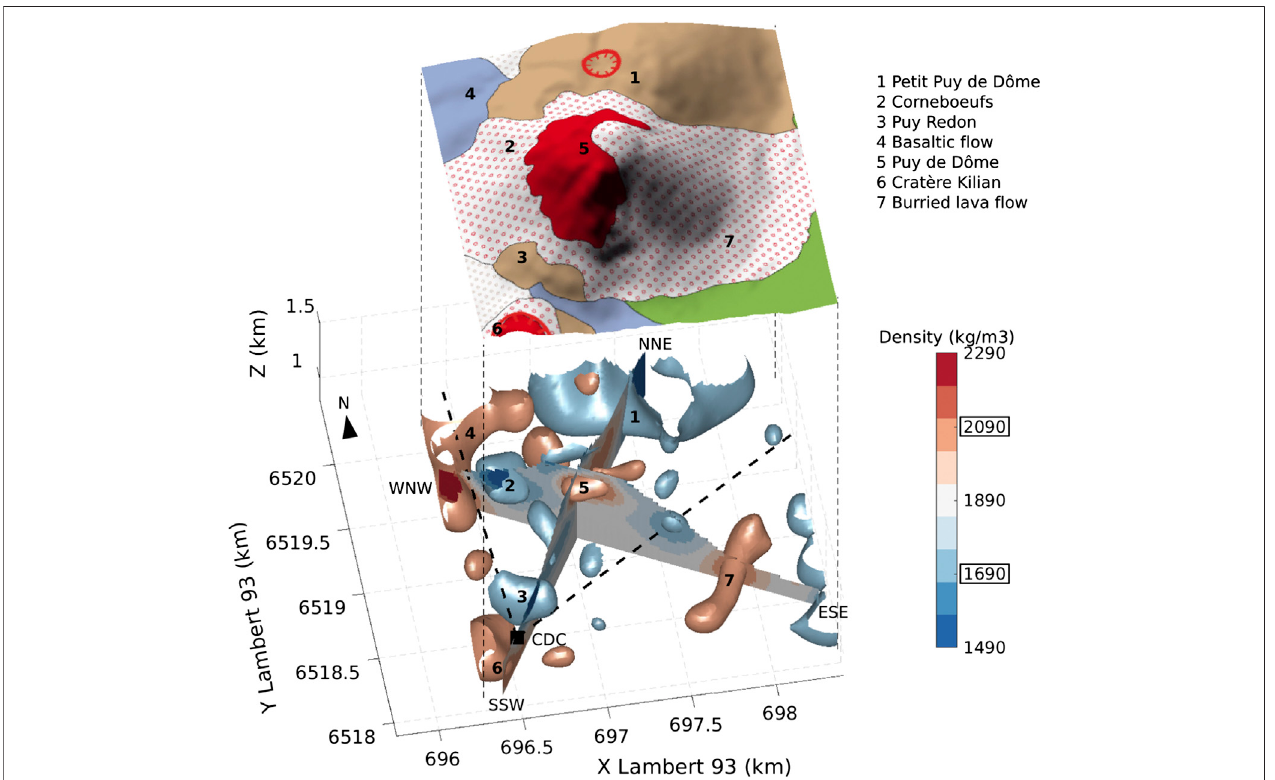
FIGURE 7 | 3D density model of the Puy de D ˆ ome volcano resulting from the joint inversion of muographic and gravimetric data, with geological map wrapped on topography. The lateral extent of the model is indicated by the blue square on Figure 1 . The averaged density is 1,890 kg/m 3 . Iso densities of 1,690 and 2,090 kg/m 3 , corresponding to the averaged density ± 200 kg/m 3 , are chosen to highlight low and high density zones in blue and red respectively. The SSW-NNE and WNW-ESE vertical sections are the same as in Figure 6 (locations indicated on Figure 2 ). The numbered features indicate the structures discussed in the article. The black square and dashed lines indicate the location of the muon detector at Col de Ceyssat (CDC) and its angle of view.